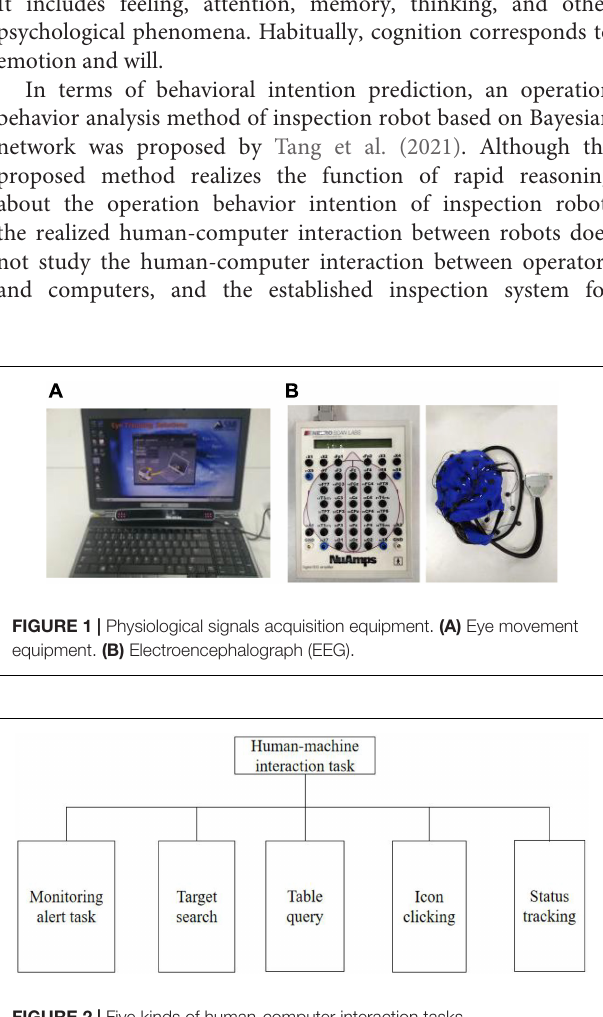
FIGURE 2 | Five kinds of human-computer interaction